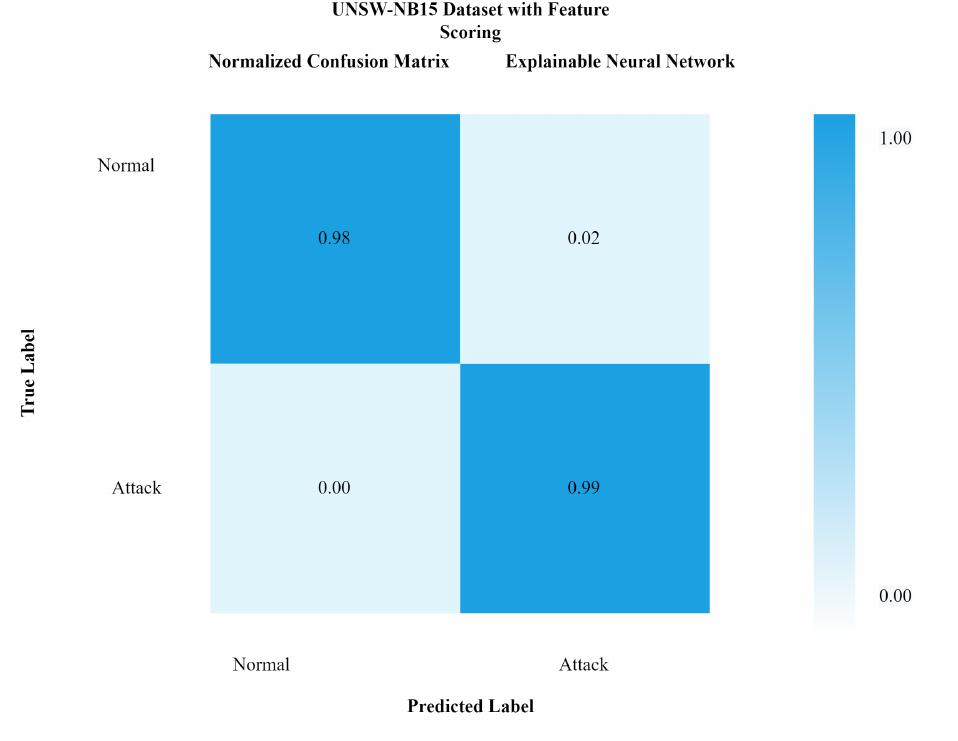
Figure 10. Confusion matrix of xNN for UNSW-NB15 with feature